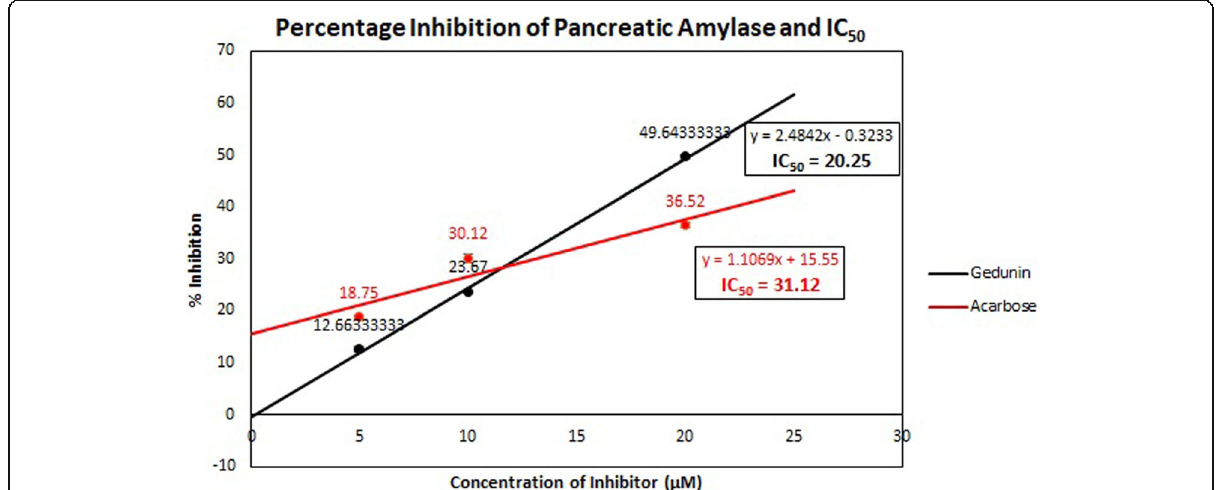
Fig. 6 Percentage inhibition of pancreatic alpha amylase at different concentrations of gedunin and acarbose (standard drug) and IC 50 . Values represent mean ± SD for three independent experiments and error bars represent standard error (SE)